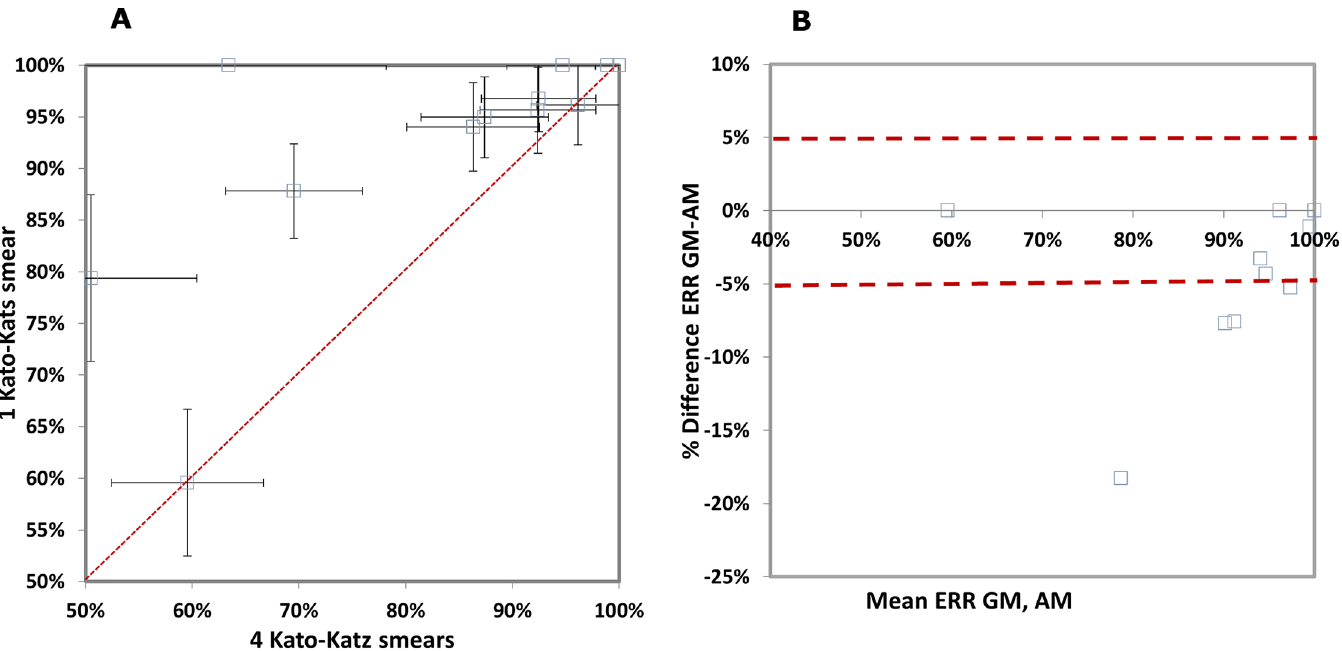
Fig 7. Comparison of cure rate (CR) calculated from a single versus quadruplicate Kato-Katz thick smears, both with estimated 95% confidence intervals (CI). A. L ’ Abbé plot. For each point, the 95% CIs are shown. The red dashed diagonal line of no difference between the ERR calculated with both metrics. B. Bland-Altman plot. The red dashed lines show the interval that determines the agreement of the two metrics, set at 5%.